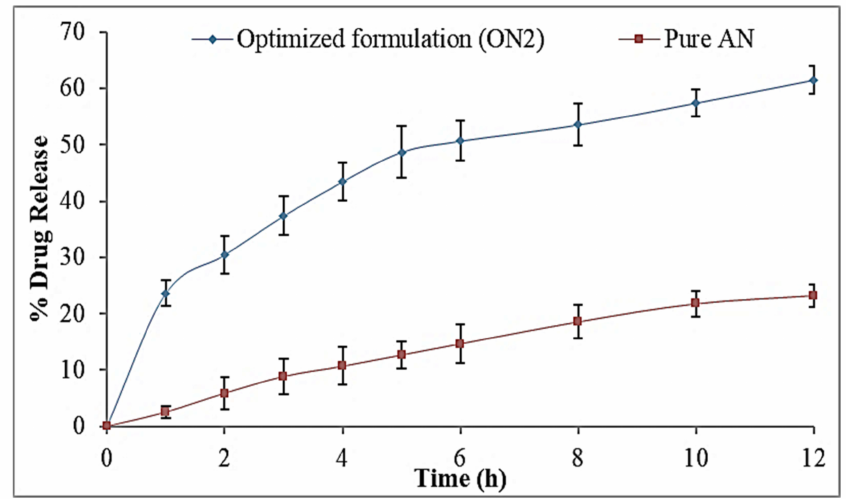
Figure 9. In vitro release study graph of pure Apigenin and optimized formulation (ON2). The study was performed in triplicate and data shown as mean ±